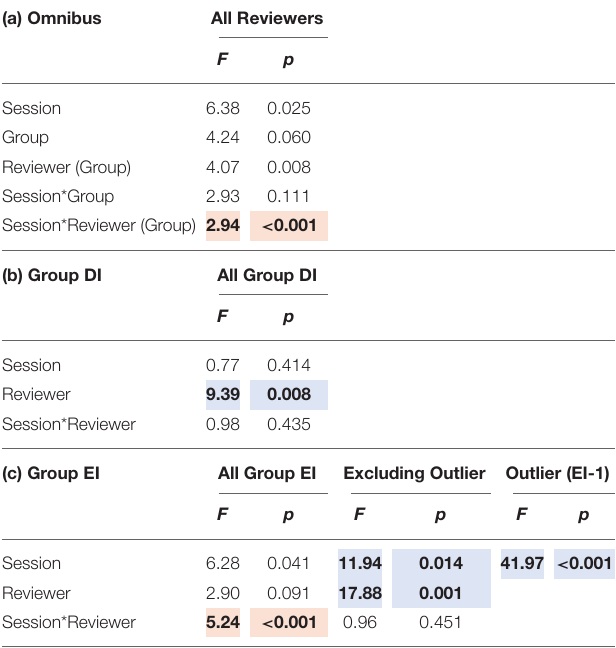
TABLE 3 | Summary of ANOVAs for session, reviewer, and group, including F statistics and p -values for each effect and their